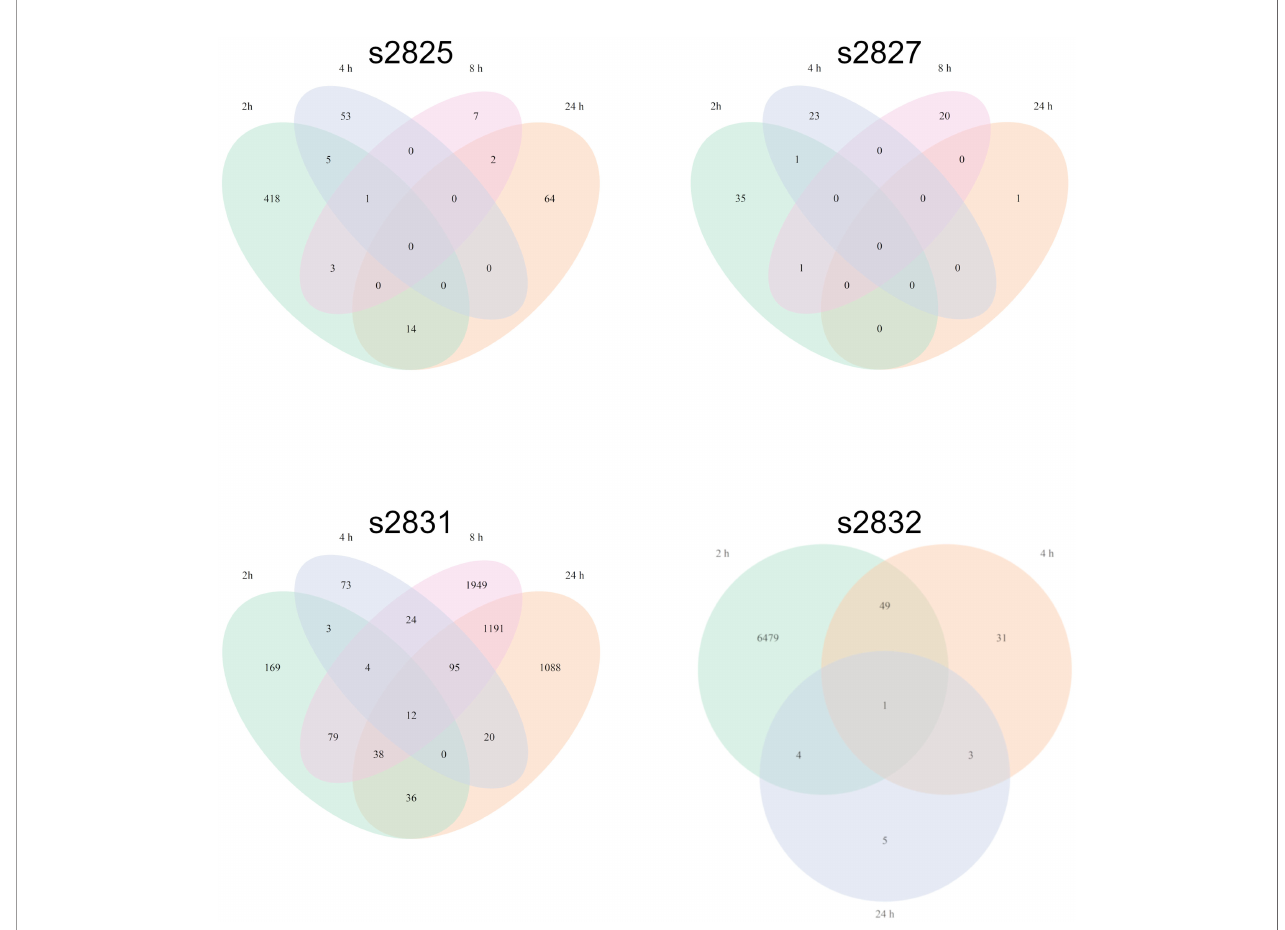
FIGURE 2 | Fusarium verticillioides transcriptomic response to four Streptomyces strains. Venn diagrams representing the overlap of F. verticillioides DEGs over all timepoints for each Streptomyces strain dual-culture. The s2832 diagram does not include the 8 h timepoint since no statistically signi fi cant DEGs were